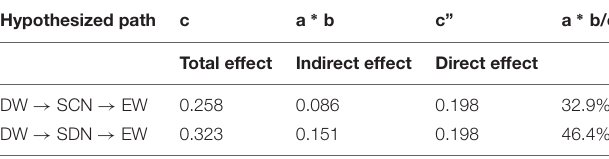
TABLE 5 | The comparison of mediating